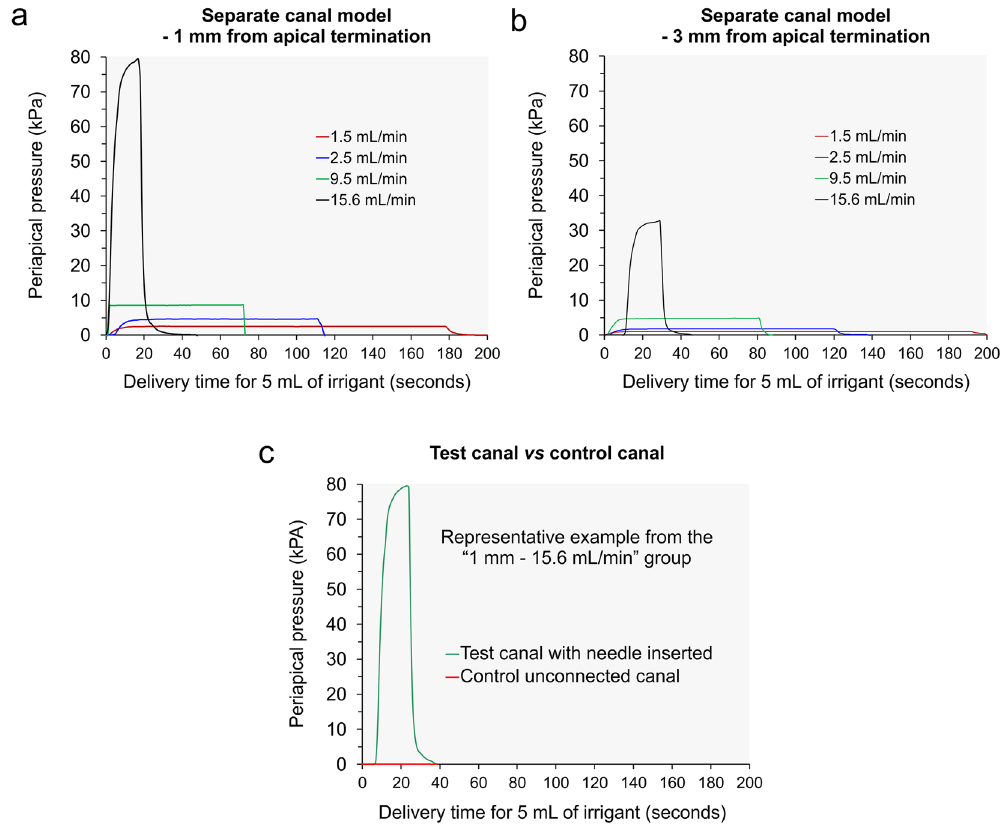
Figure 4. Apical fluid pressures generated in the separate canal model with different fluid flow rates. ( a ) Representative pressure-time plots produced by inserting the side-venting needle to 1 mm above the faux apical terminus in the test canal. ( b ) Representative pressure-time plots produced by inserting the side-venting needle to 3 mm above the faux apical terminus in the test canal. ( c ) Representative example of a superimposed pressure-time plot produced in one recording of the test canal and the control unconnected